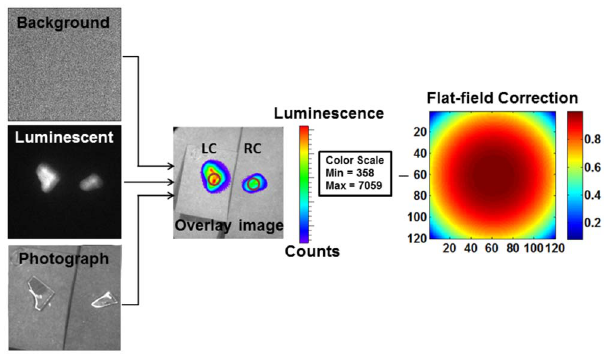
Figure 2. ROI selection on IVIS-200 images. Three images– background, luminescent, and photograph were collected using IVIS- 200 to create an overlay image. Then, a region of interest (ROI, shown with circle) was selected on the left carotid (LC) and right carotid (RC) arteries. The overlay image was corrected for field flatness, which was specific to the camera used in the IVIS-200 imaging system.